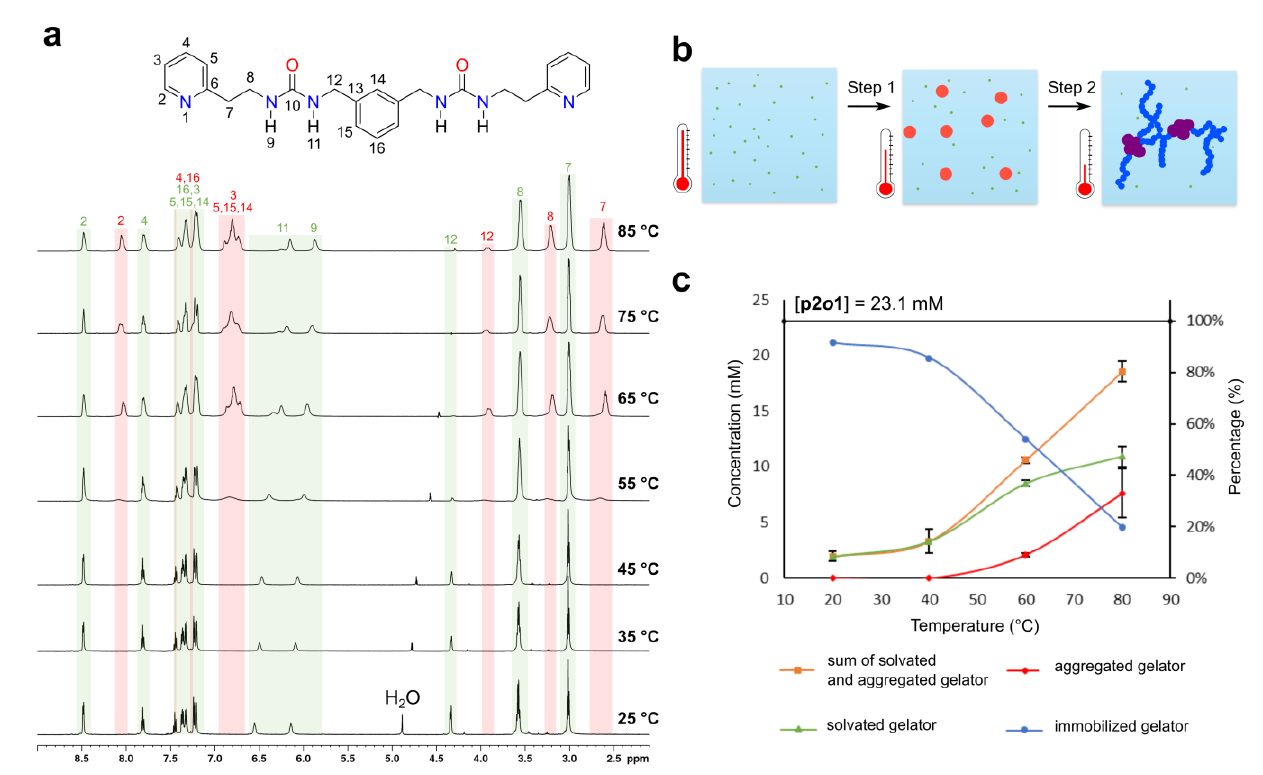
Figure 3. VT-qNMR quantifies and rationalizes the heat-triggered hydrogelation mechanism. ( a ) 1 H solution-state VT-NMR at 25, 35, 45, 55, 65, 75, and 85 ◦ C with full signal assignment. Experiments started at 25 ◦ C from a gelled sample of p2 o 1 in H 2 O:D 2 O (9:1) at a concentration of 1.0% w / v . Water suppression was accomplished through excitation sculpting. Note that due to this water suppression, the aliphatic signal around 4.40 ppm was diminished. Peaks marked in red originated from p2 o 1 in an aggregated state, while peaks marked in green originated from p2o1 in a free solvated state. ( b ) Schematic representation of the stepwise gelation mechanism. ( c ) Plot of the average concentrations and percentage of the different material phases of p2 o 1 that occurred upon heat-triggered hydrogelation determined through Bruker’s ERETIC2 quantification tool. Green = free solvated gelator molecules, red = mobile aggregated particles, and blue = immobilized gel network, which were estimated by subtracting the sum of the solvated and aggregated concentrations (orange) from the total concentration of p2o1 of the sample (23.1 mM). Each experiment was performed in triplicate on different samples by increasing the temperature from 20 ◦ C to 80 ◦ C in steps of 20 ◦ C. The average results are accompanied by their standard deviation for each temperature.